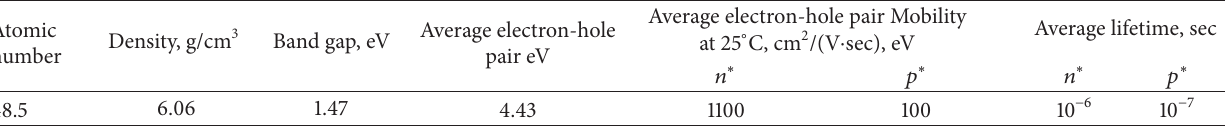
Table 1: The characteristic properties of CdTe detector.